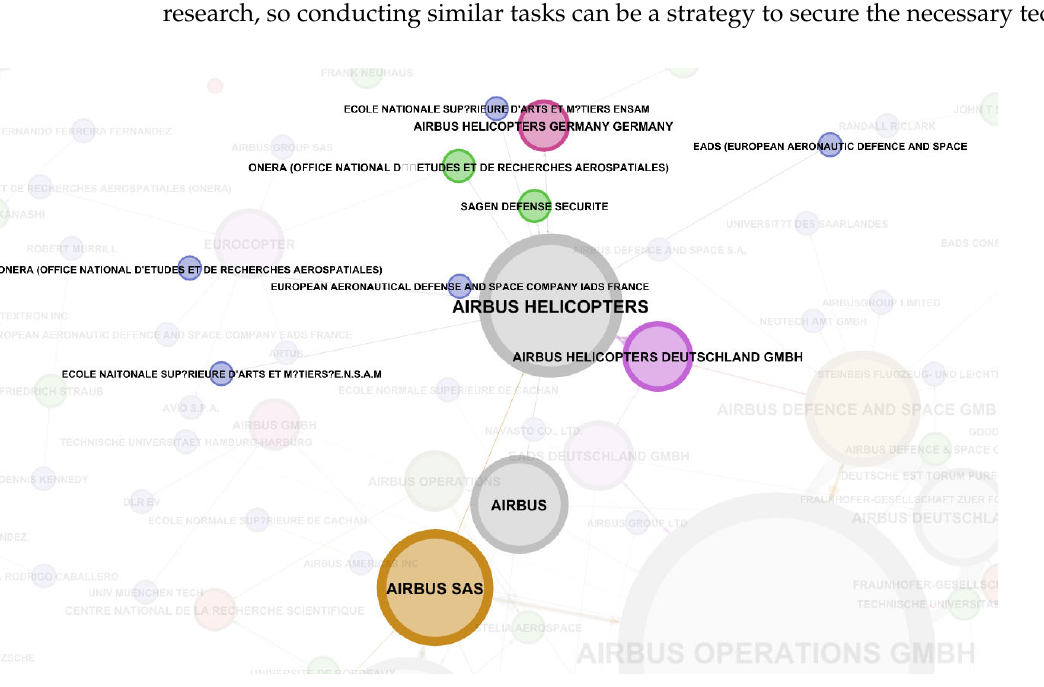
Figure 10. Network Analysis of Cooperative Relationships.